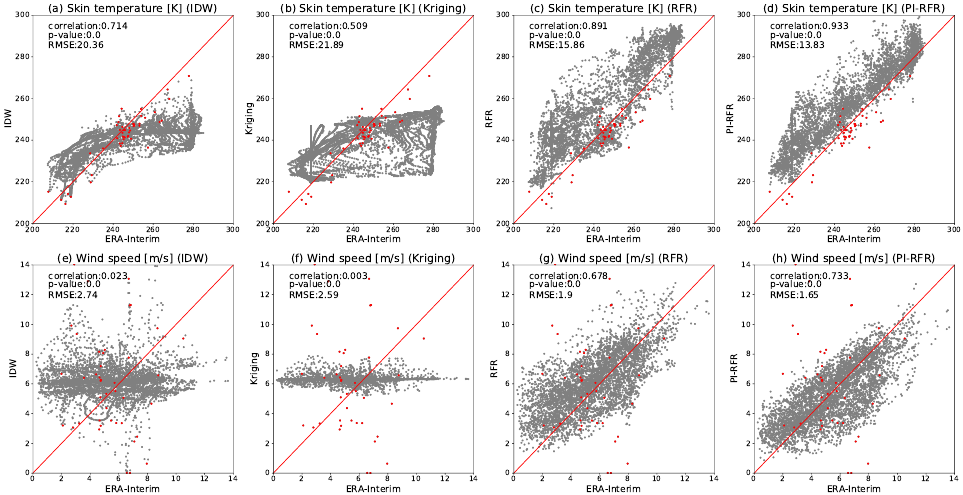
Figure 14. Correlation between the reconstruction results of IDW ( a , e ), Kriging ( b , f ), RFR ( c , g ) and PI-RFR ( d , h ) and ERA-Interim reanalysis data for skin temperature and wind speed. The red points represent the values of observation sites. Gray points represent reconstructed